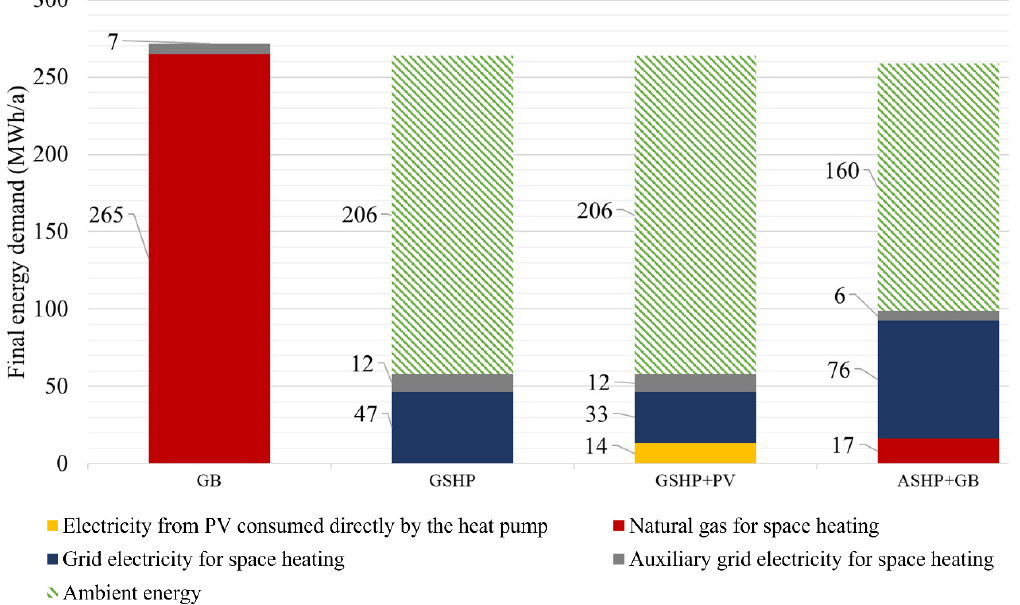
Figure 4. Annual final energy demand for space heating. Notes. GB: Gas boiler, GSHP: Ground-source heat pump, GSHP + PV: Ground-source heat pump with a photovoltaic system, ASHP + GB: Air-source heat pump backed up with a gas boiler.